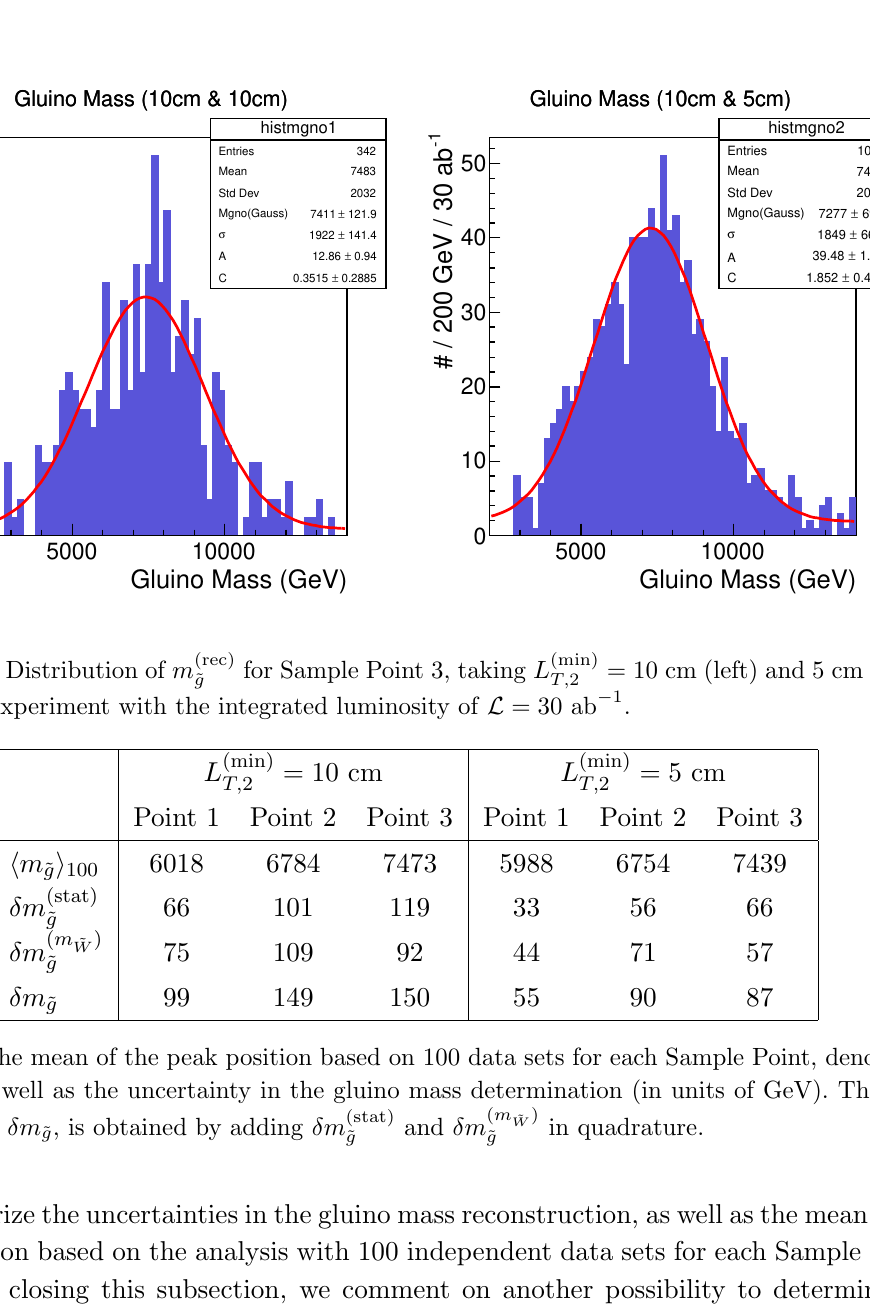
and (cid:14)m ( m ~ W ) in ~ g ~ g